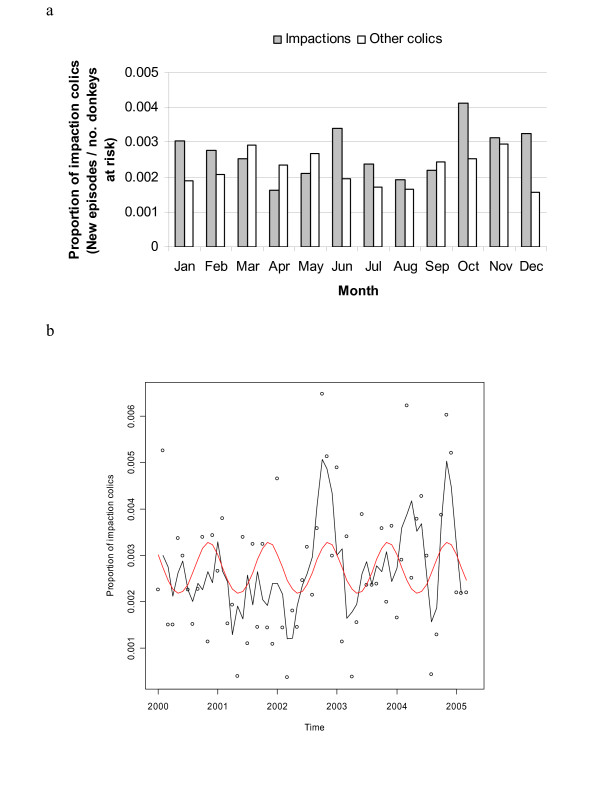
a – Proportion of all colics and impaction colics during each month of the year from January 2000 until March 2005. b – Time series analysis of the proportion of impaction colics during each month from January 2000 until March 2005. Plot shows proportion of impaction colics per month (open circles), fitted values from the regression model with 12 month cycle (red line) and raw data after smoothing with 3 month moving average (black line) which demonstrates a 12-month seasonal pattern in the occurrence of impaction colic with a peak in late autumn.